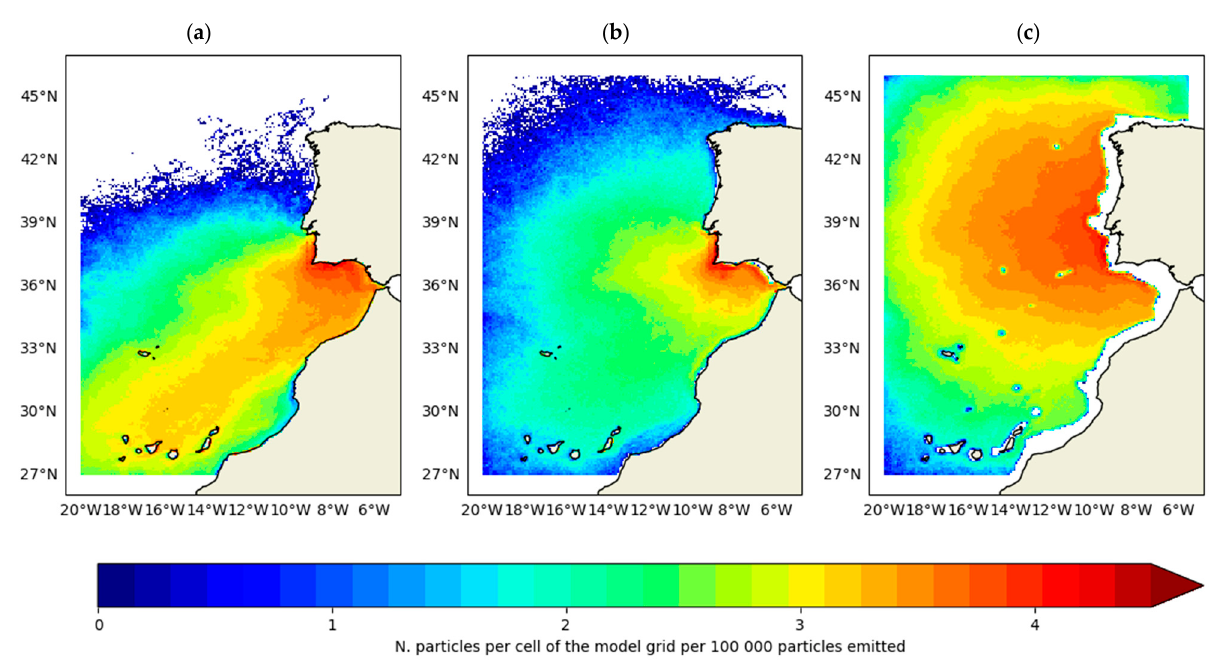
Figure 3. Maps showing the cumulative particle concentration per 100,000 particles detected in 0.8° grid cell on a logarithmic color scale for particles carried by currents ( a ) at the surface (left box), ( b ) at a depth of 30 m (middle box), and ( c ) at a depth of 800 m (right box). The simulation results shown in Figure 4 represent the travel time of the marine micro- plastics originating from the SW Iberian coast. These maps show the time required for the particles to be transported away from the Iberian coast towards nearby neighboring regions at three different depths. Here, the travel time was evaluated by averaging the age of the particles detected in each grid cell of the model with reference to the time of particle release.